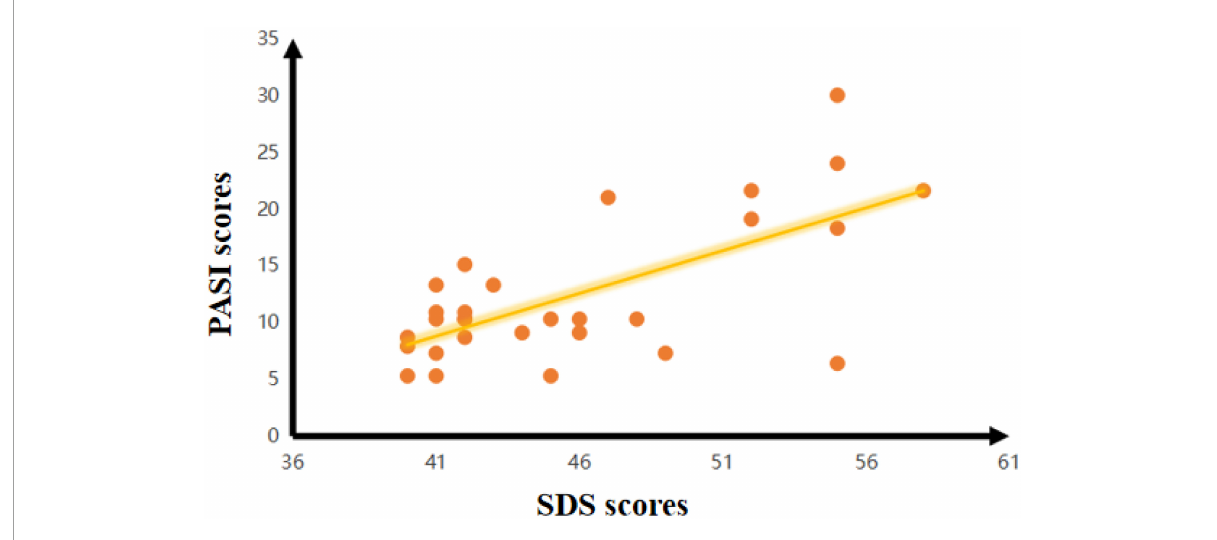
FIGURE3 The relationships between PASI and SDS scores in PPD.